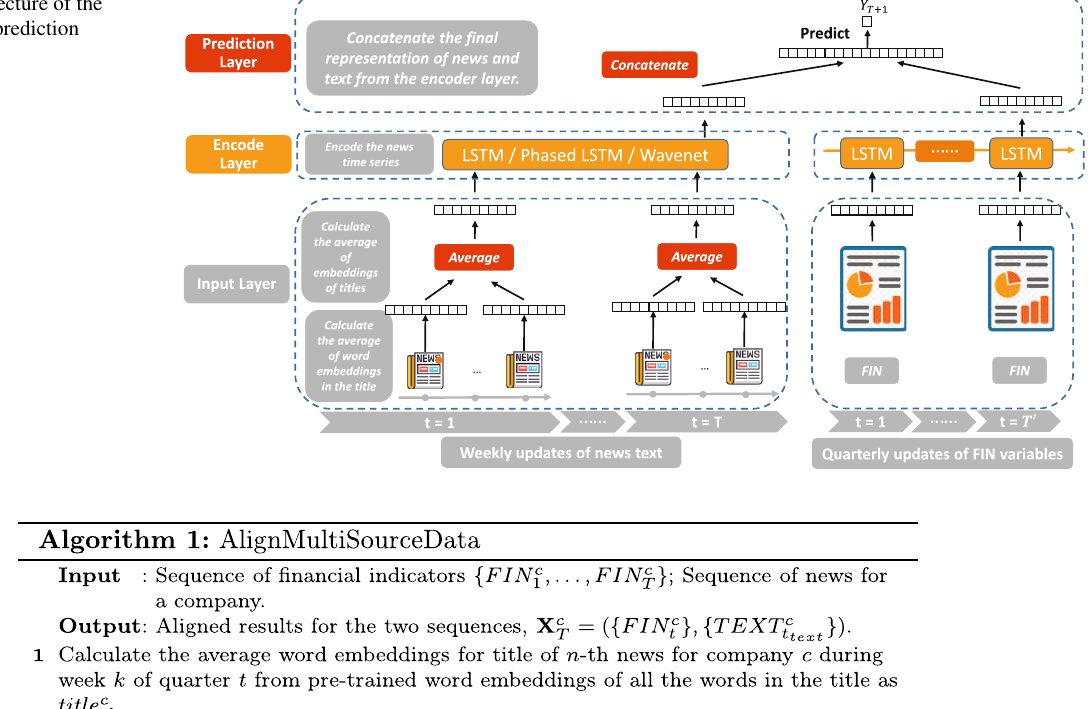
Fig. 2 The architecture of the proposed neural prediction